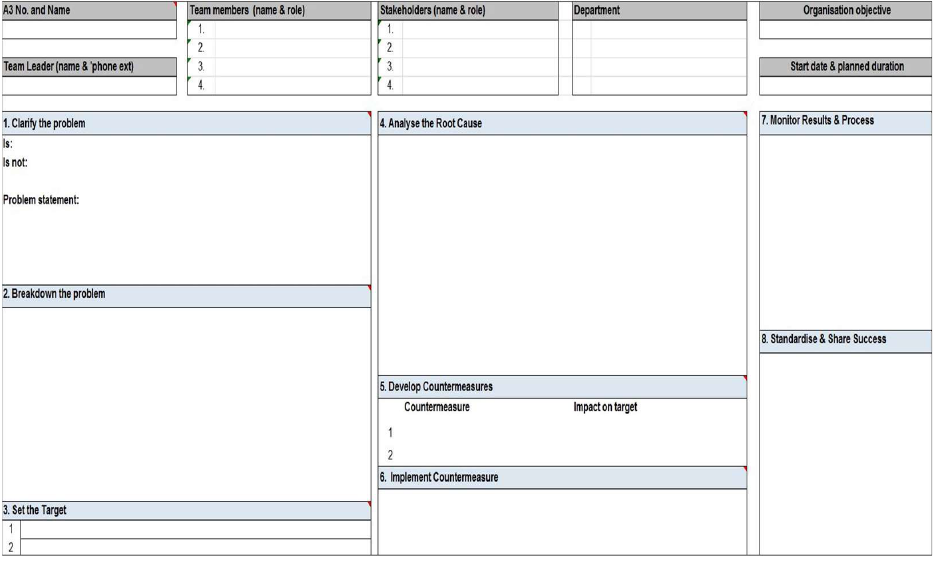
Figure 3. A3 template for immediate visual identification of process issues, root causes, and possible solutions .